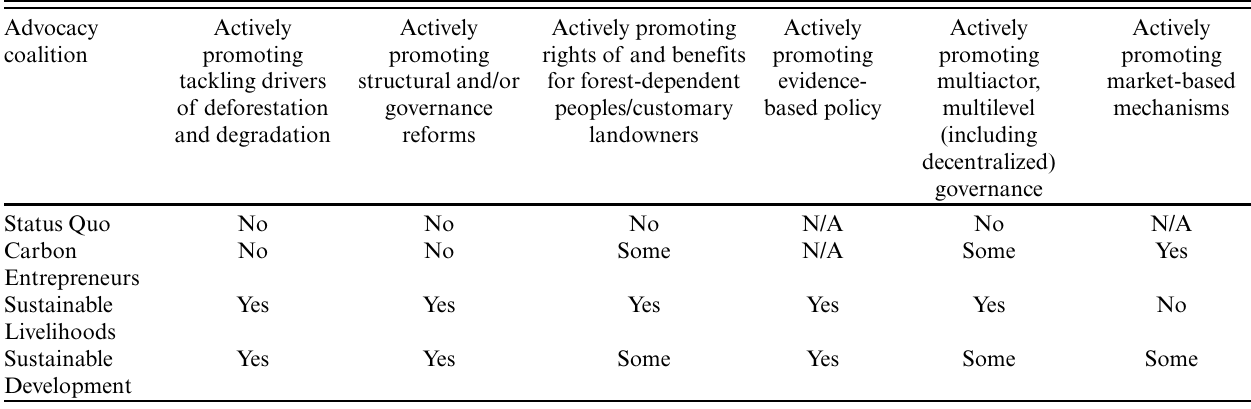
Table 1 . Criteria used to assign actors to